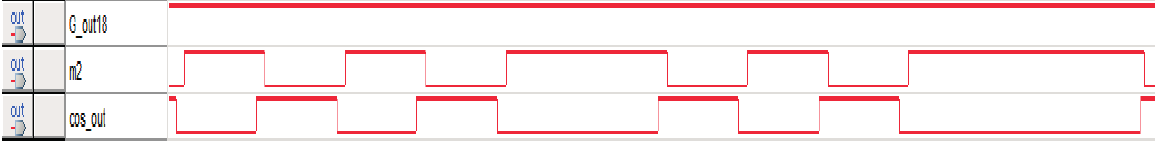
Figure 29. The waveform of the code acquisition